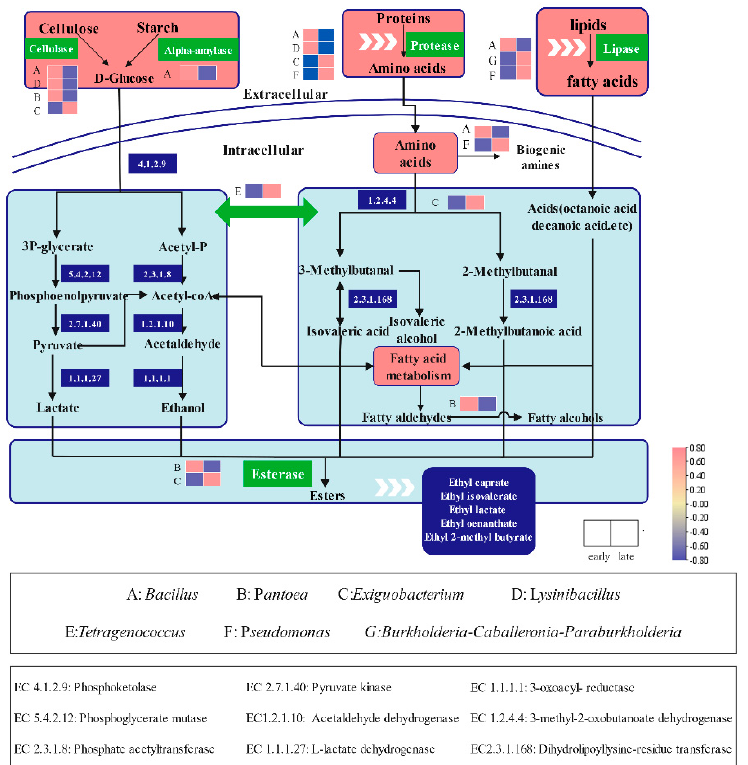
Figure 7. The key metabolic pathways involved by seven core microbiota of aroma compounds formation in sufu fermentation, the green blocks represent Involved enzymes, the red blocks in the heat map represent the early stage, and the blue blocks represent the late stage.